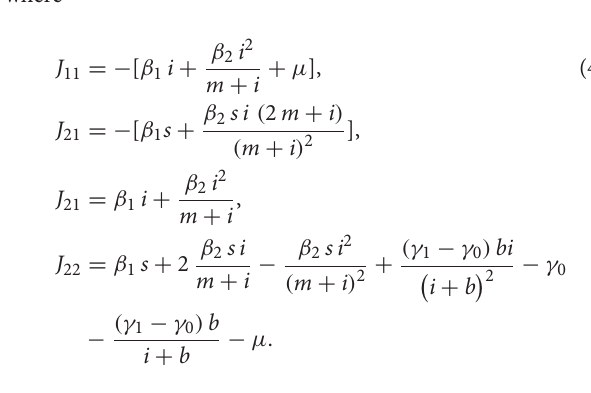
Frontiers in Physics |